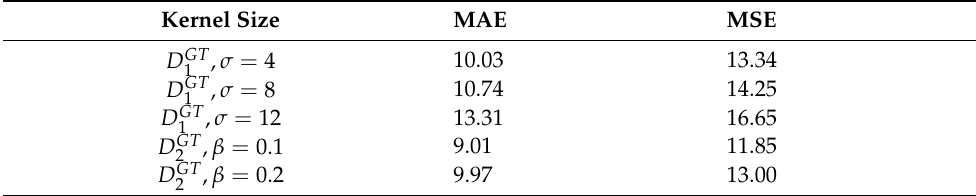
Figure 8. Estimated density maps of different DM-Nets. Table 3. The influence of different Gaussian kernel sizes on the model